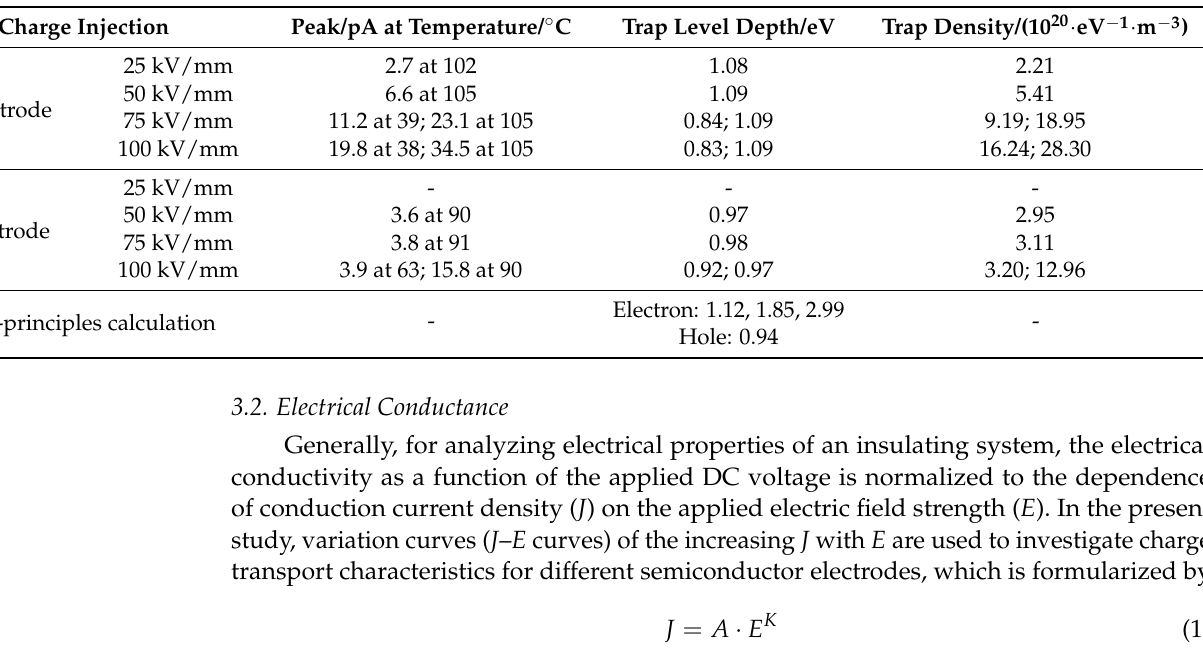
Table 1. Trap energy level distributions in PET for charge injections individually with different semiconductor electrodes under various applied electric fields.